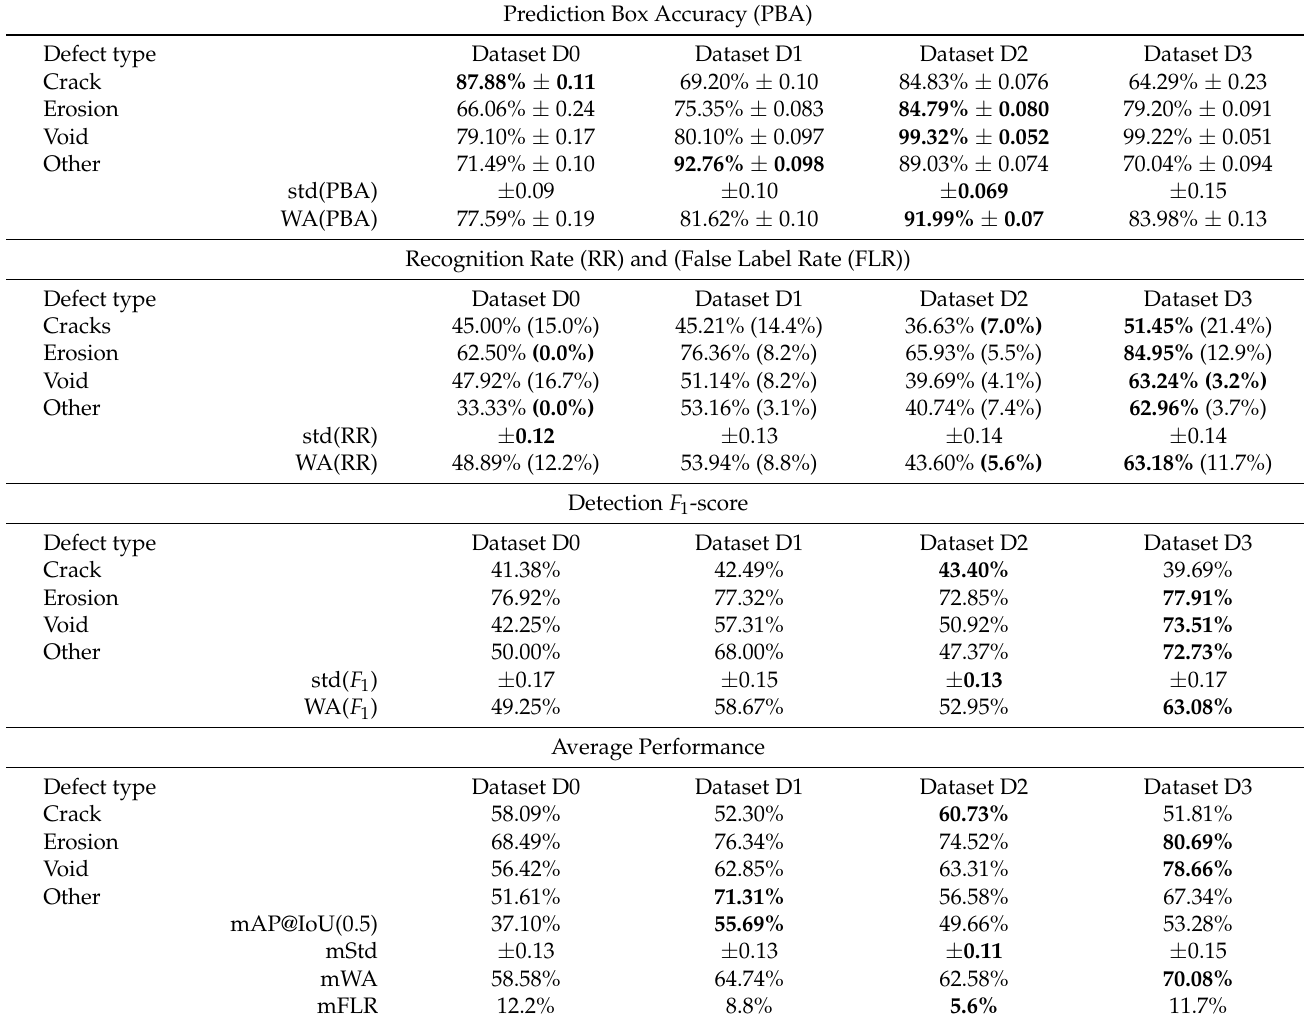
Table 5. YOLOv3: Performance evaluation on test dataset. WA is the weighted average as defined in (11). mWA is the mean WA of PBA, RR, and Detection F 1 -score. mStd is the mean std of PBA, RR, and Detection F 1 -score. mFLR is the weighted average of FLR across all defect types.